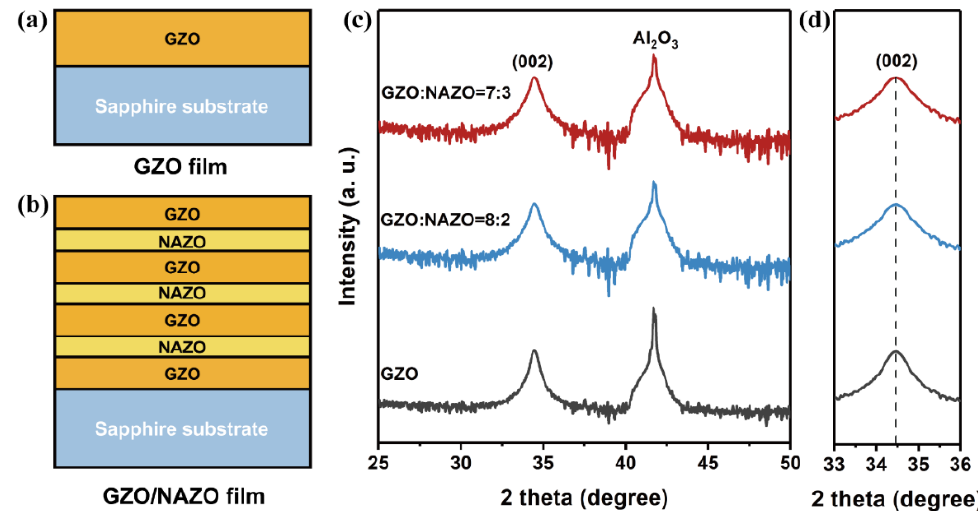
Figure 1. Schematic illustrations showing two kinds of designed thin films, one is GZO film ( a ), the other is GZO/NAZO film ( b ); ( c ) the XRD patterns of GZO and GZO/NAZO thin films; ( d ) an enlarged section of (002) peaks around 34.5° in ( c ).